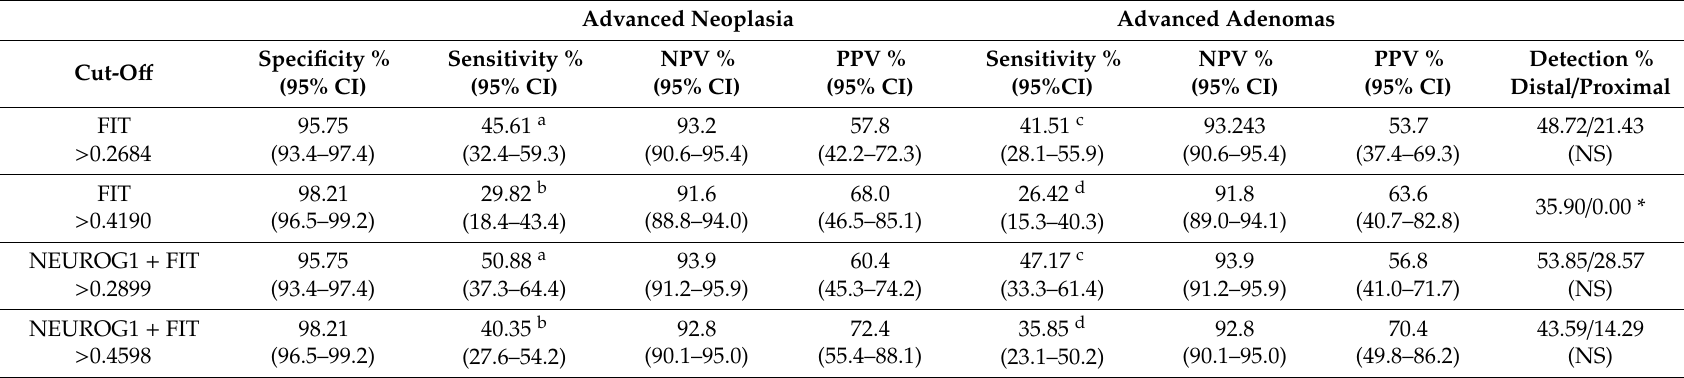
Table 4. Diagnostic performance of the models for the detection of advanced neoplasia and advanced adenomas in the screening